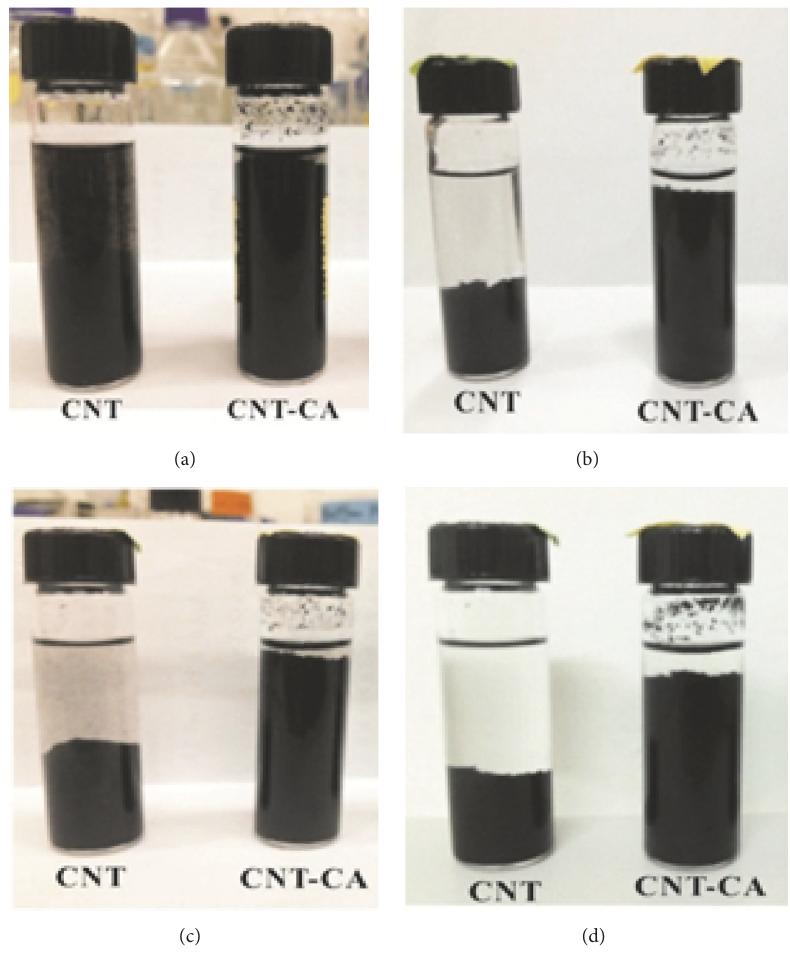
Figure 3: CNTs and CNTs/CA dissolved in ethanol. (a) 0 h. (b) 4 h. (c) 8 h. (d) 16